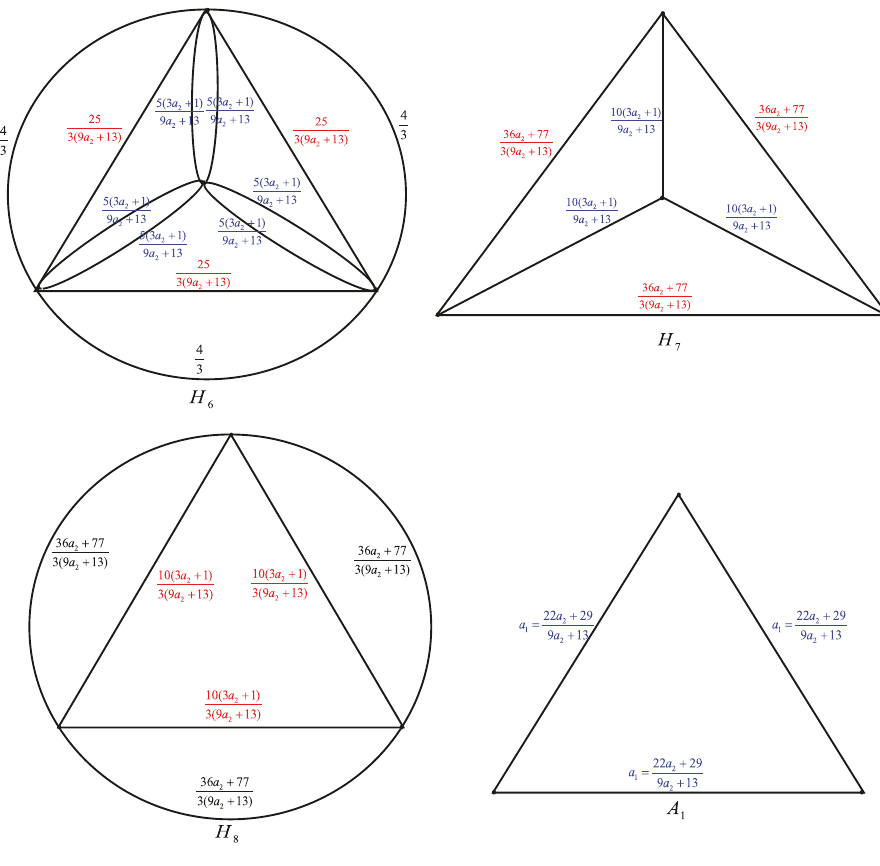
Figure 4: The transformations from 𝐴 2 to 𝐴 1